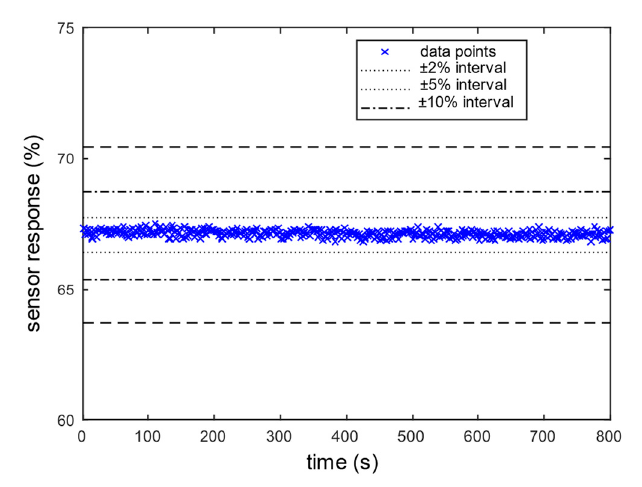
Figure 12. Measured temporal stability of the Sun simulator beam [50].